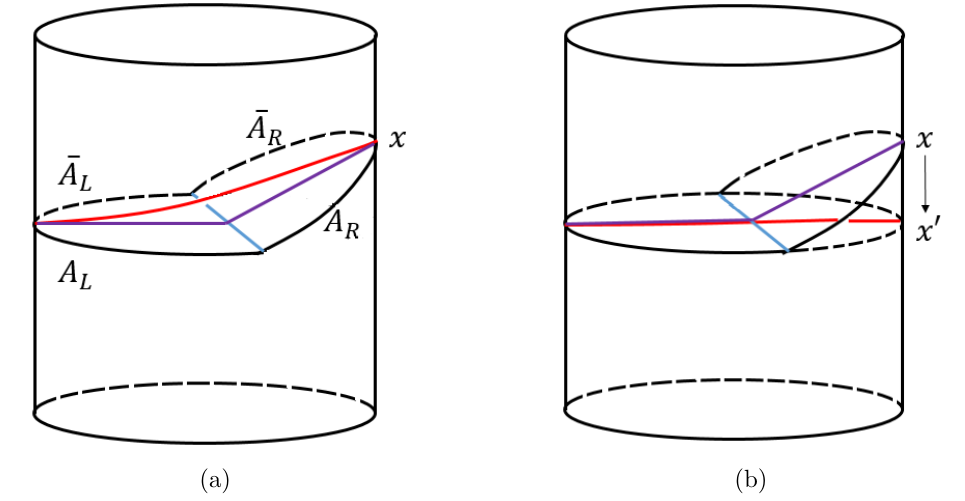
Figure 5. The sphere in the vacuum situation is similar. In the (cid:12)gures, we show how it works in AdS 3 . (a) The surfaces (cid:13) ( A ), (cid:13) ( R ) and (cid:13) R ( A ) are in color red, blue and purple, respectively. (b) The role of the modular (cid:13)ow is to move the right endpoint of A , x . The minimum is obtained when x is shifted to x 0 in the t = 0 slice. Because of the symmetries, the purple and red surfaces have the same